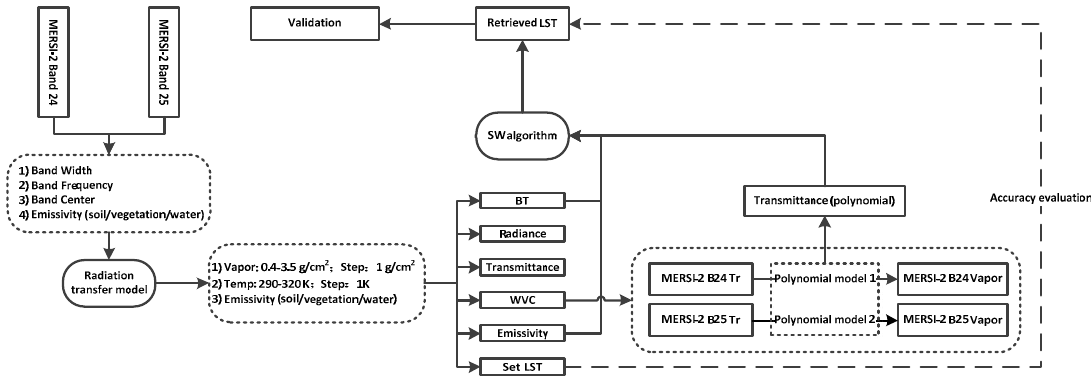
Figure 11. Technical route of validation through standard atmosphere simulation.